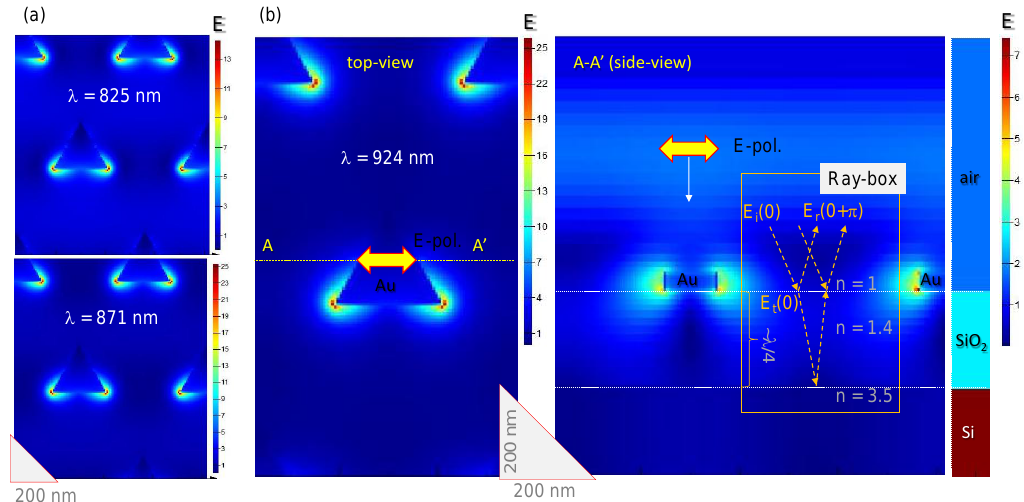
Figure A2. FDTD simulations for the L = 220 nm w = 200 nm case. ( a ) E-field enhancement at λ = 825 nm (see Figure 2b for comparison) and 871 nm which are close-to-maximum. ( b ) Top- and side views of E-field enhancement for a linearly polarised plane wave. Refractive index cross-section is shown on right-side to distinguish the lateral cross-sections. Note, the cross-section A-A’ is made though the center of triangle and not at the largest intensity vertexes. Incident light has E x polarisation. Inset “ray-box” shows schematically the phase change upon reflection from interfaces for the incident, transmitted and reflected E-fields E i , t , r in ray optics presentation [18]. In addition to the Fresnel coefficient defined phase changes, a propagation phase is adding up and amounts to π for traversing a λ /4 thickness twice upon back-reflection from